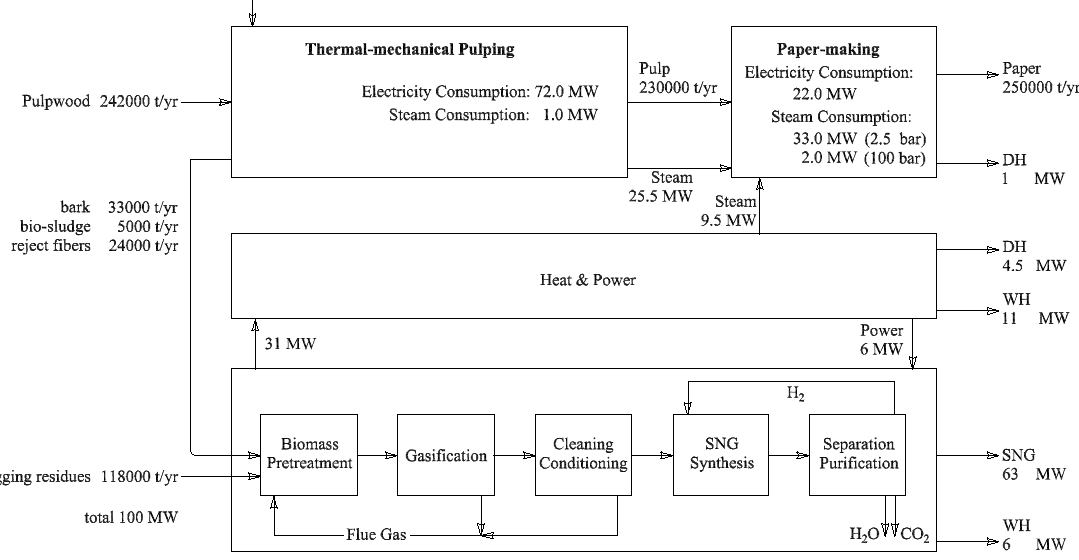
Figure 3. Flowsheet of the TMP + BtSNG process with mass and energy inputs and outputs